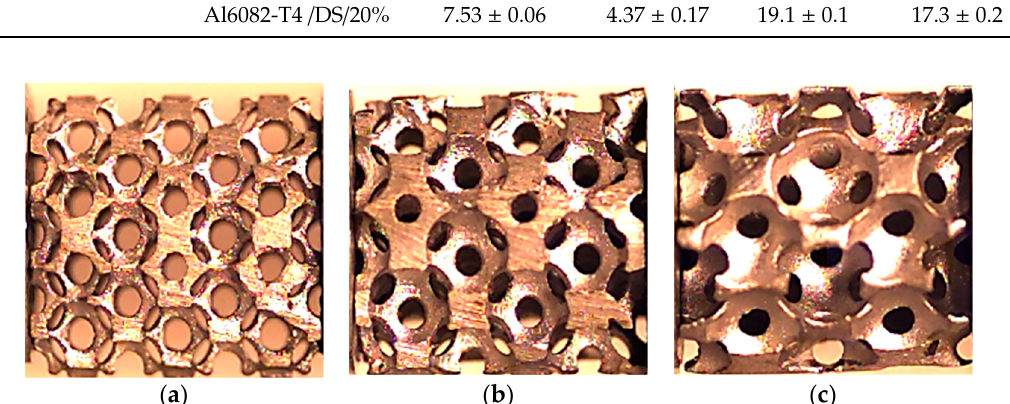
Figure 1. Samples with a US structure and nominal relative densities of: ( a ) 20%; ( b ) 40%; and ( c ) 60%.